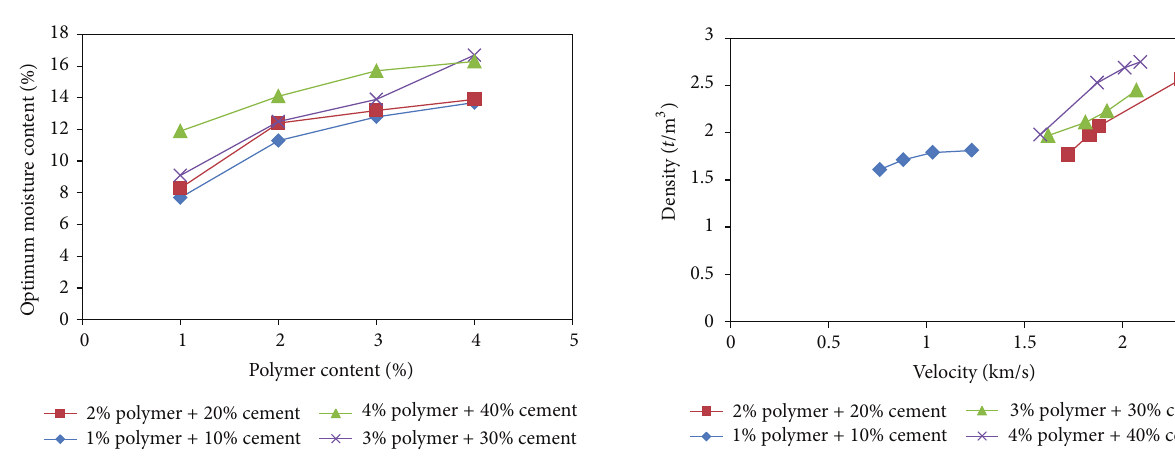
Figure17:Ultrasonicpulsevelocitytestprocedureinwetconditions for 7 days.